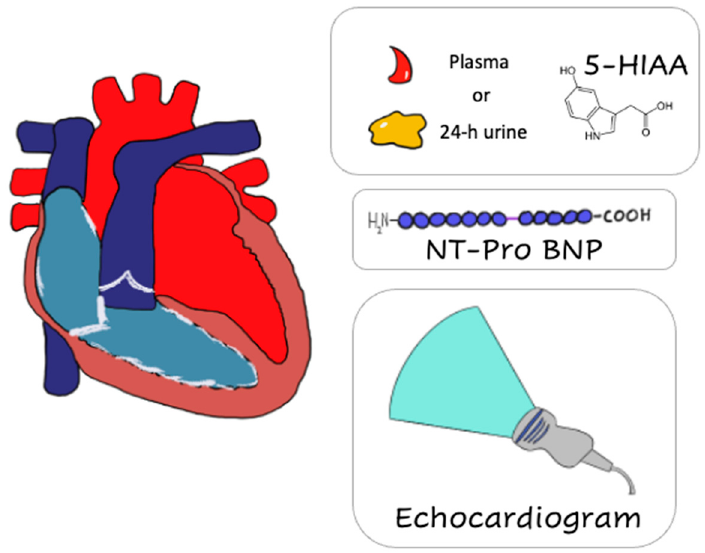
Figure 2. Main diagnostic modalities for the screening and diagnosis of Carcinoid Heart Disease. NT-pro BNP, N-terminal pro–B-type natriuretic peptide; 5-HIAA, 5-hydroxy-indole acetic acid.